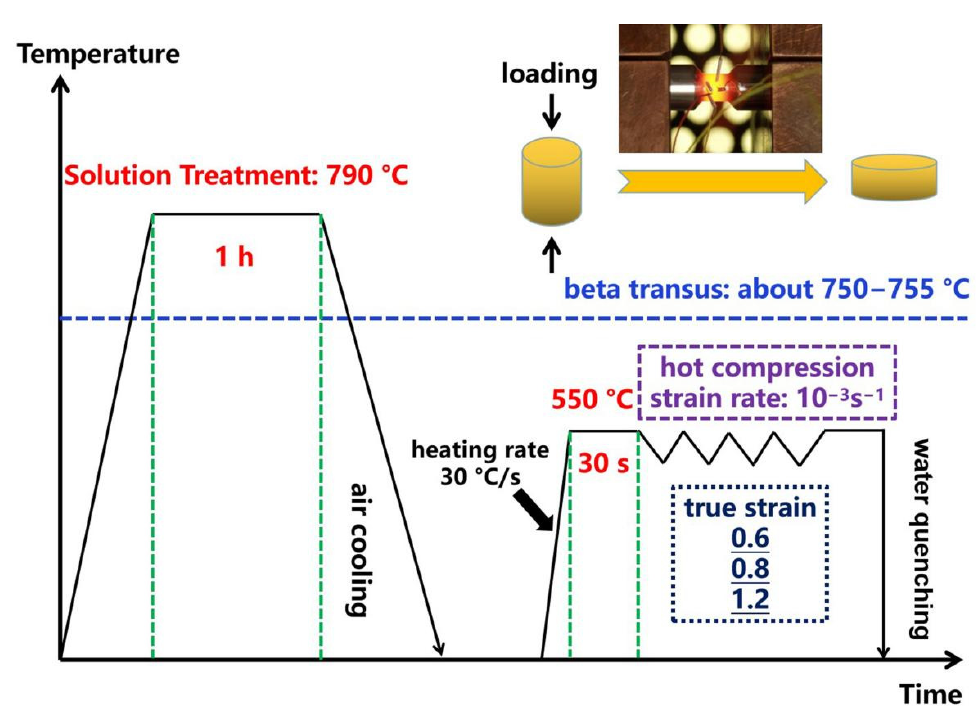
Figure 3. A schematic diagram of the isothermal deformation test.